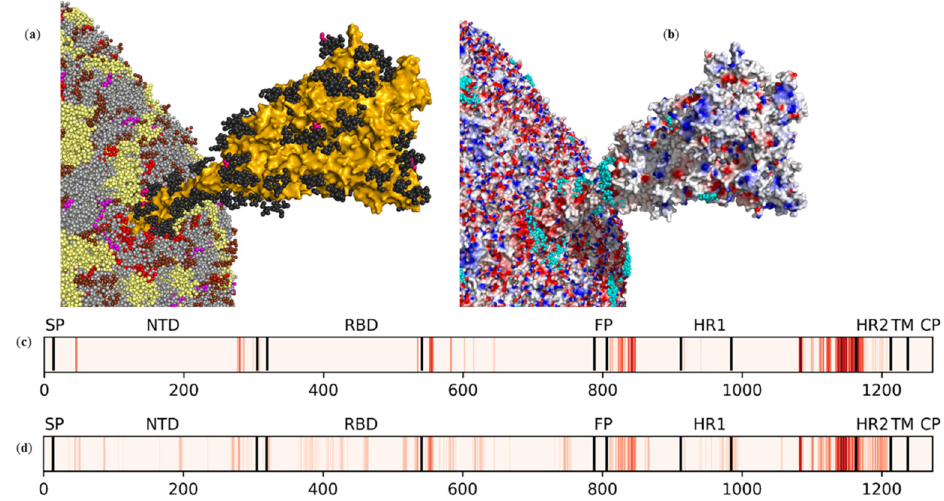
Figure 4. Effects of SARS-CoV-2 S protein glycosylation on ZnPcChol 8+ binding. The local region of SARS-CoV-2 envelope with the S protein embedded into viral membrane ( a ), and molecular surface distribution of electrostatic potential from − 100 mV (red) to +100 mV (blue) ( b ). Lipids and M proteins are the same as in Figure 1a,d. The S protein is shown as a mustard surface with black neutrally charged glycans and fuchsia negatively charged glycans. CG beads representing the Zn atom of ZnPcChol 8+ molecules in complexes with SARS-CoV-2 envelope are shown as cyan spheres ( b ). The view corresponds to the blue frame in Figure 1a. The binding ability of non-glycosylated ( c ) and glycosylated ( d ) S proteins in relation to ZnPcChol 8+ .